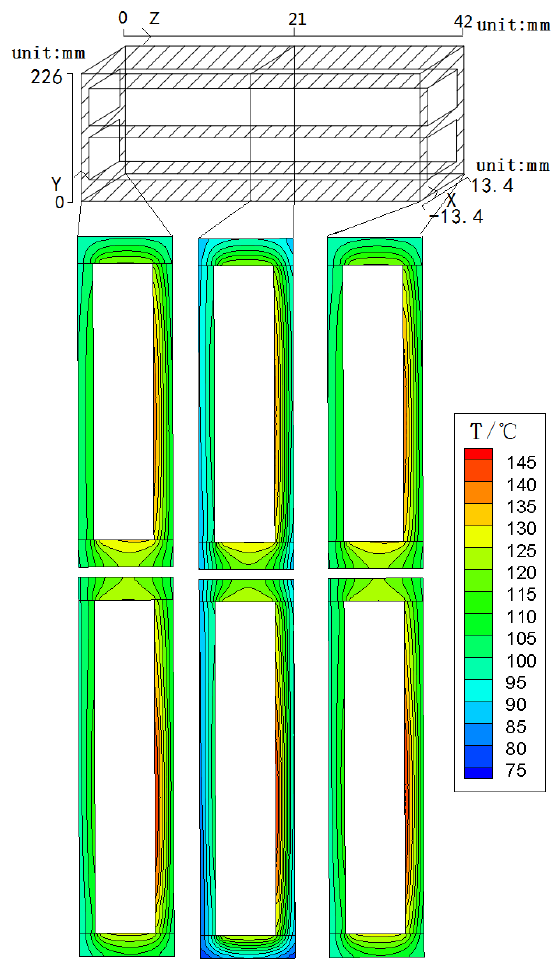
Figure 11. The main insulation temperature distribution along the circumferential–radial in the case of stator main insulation unilateral shelling δ = 1.0 mm. stator main insulation unilateral shelling δ = 1.0